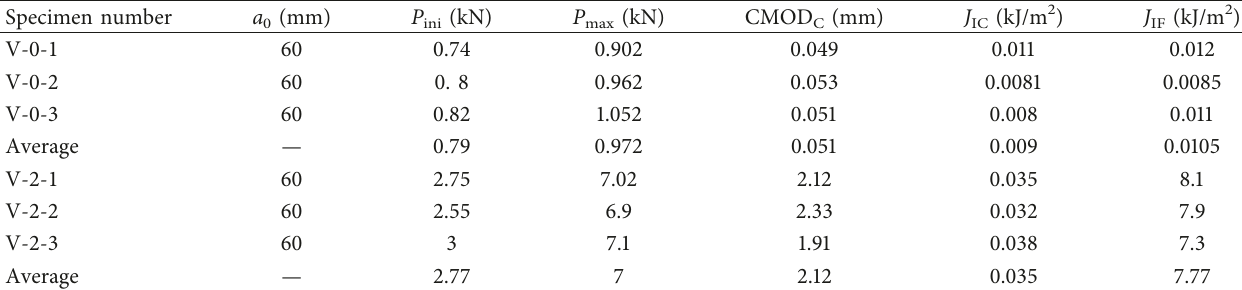
Table 2: Fracture parameters from three-point bending beams.